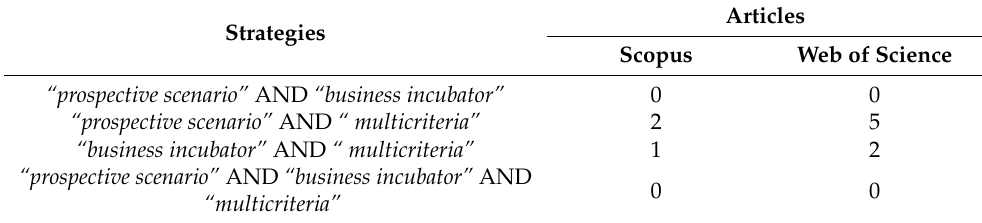
Table 1. Strategies and results.